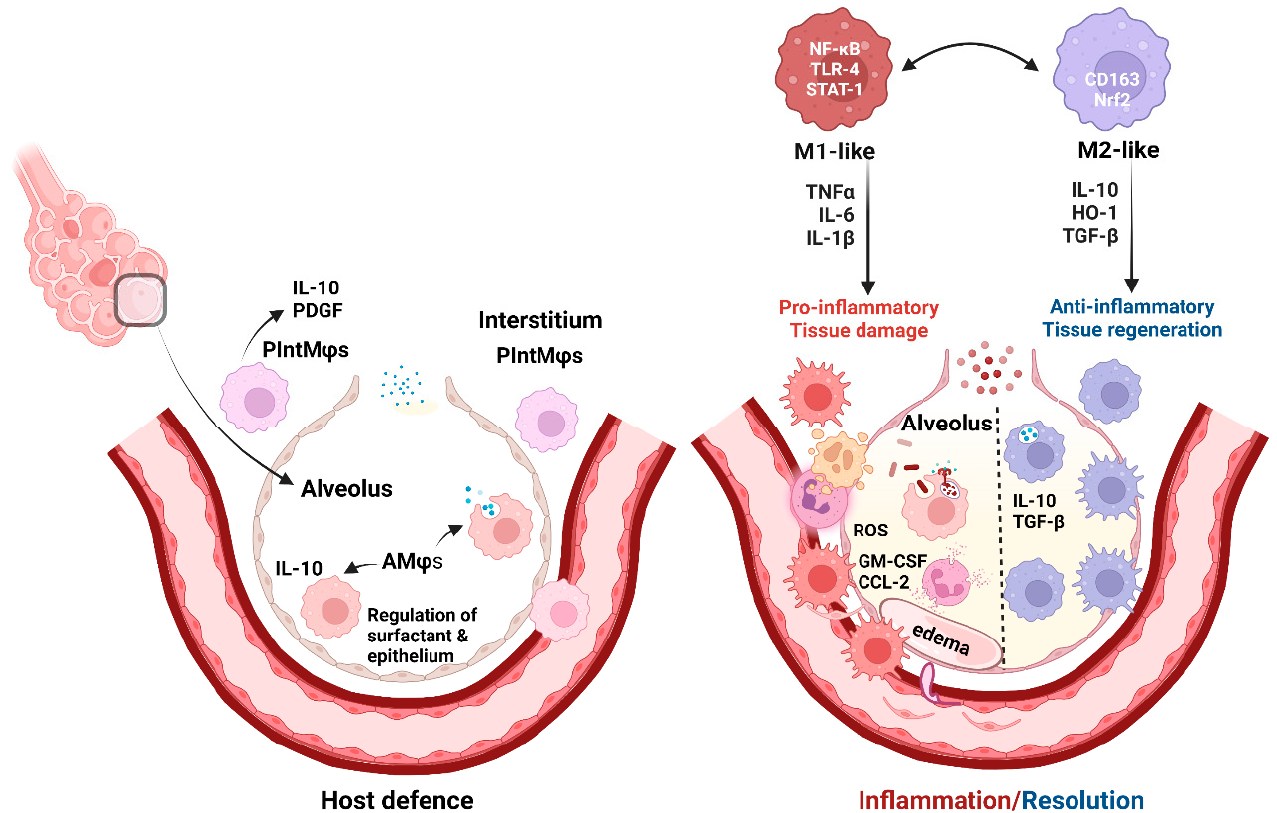
Figure 1. Pulmonary macrophages in host defense and inflammation/resolution (created with Bio ‐ Render.com).